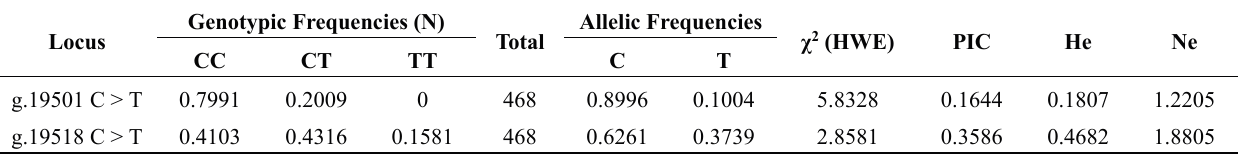
Table 2. Genotype frequencies (%) of the SIRT2 gene for the SNPs in the Qinchuan cattle populations. Note: HWE, Hardy-Weinberg equilibrium; χ 0.052 = 5.991, χ 0.012 = 9.21. Genotypic Frequencies (N) Allelic Frequencies Locus Total χ 2 (HWE) PIC He Ne CC CT TT C T g.19501 C > T 0.7991 0.2009 0 468 0.8996 0.1004 5.8328 0.1644 0.1807 1.2205